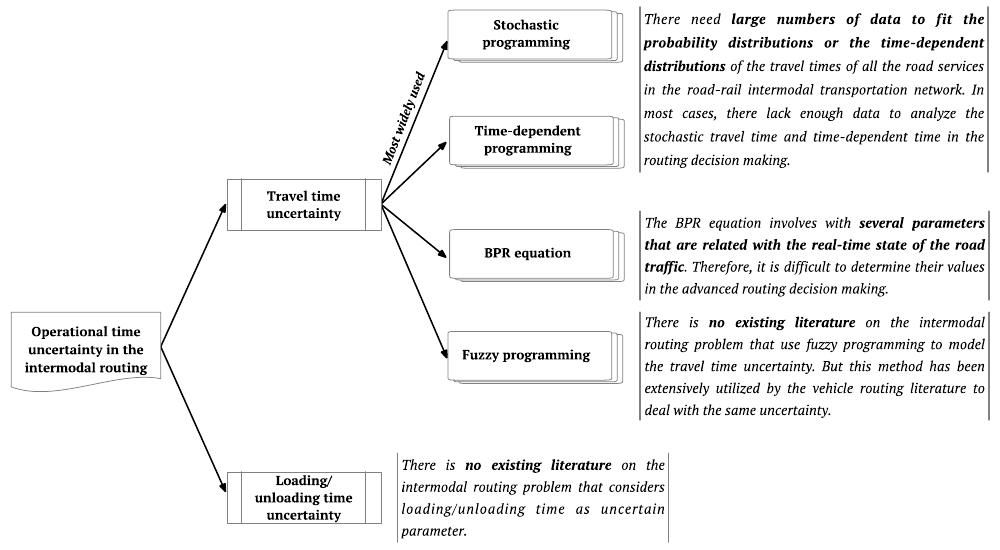
Figure 4. Formulations of the time uncertainty in the intermodal routing problem.